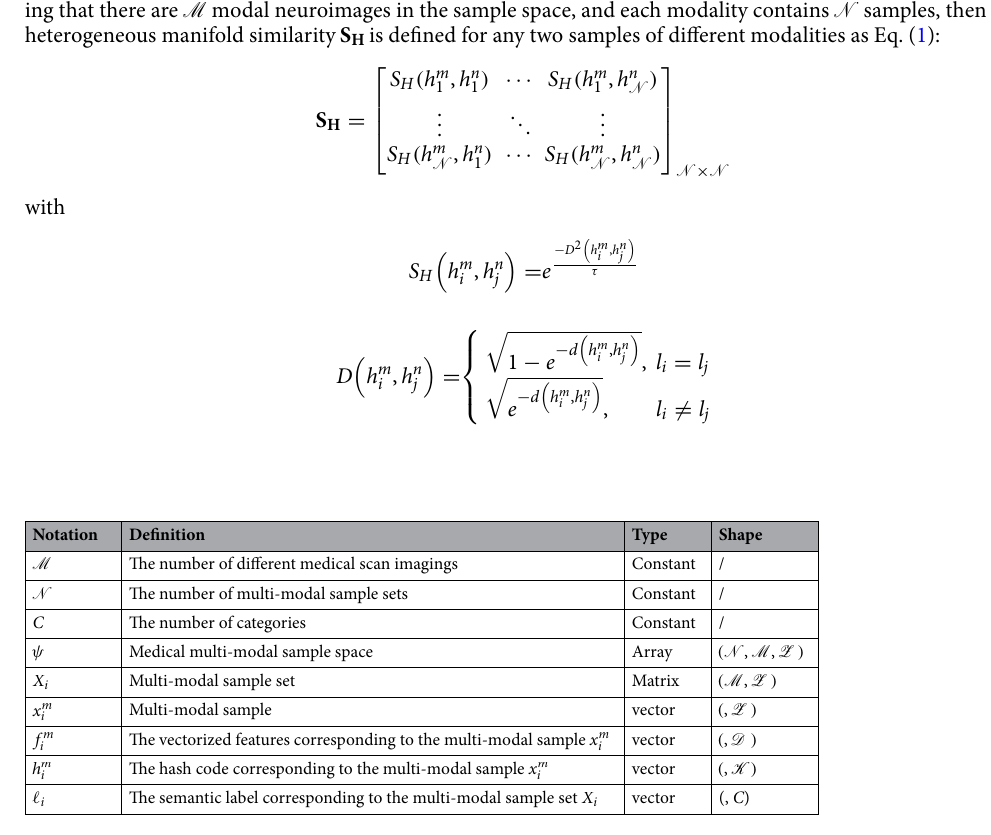
Table 1. The terms, notations, definitions and types involved in this work.